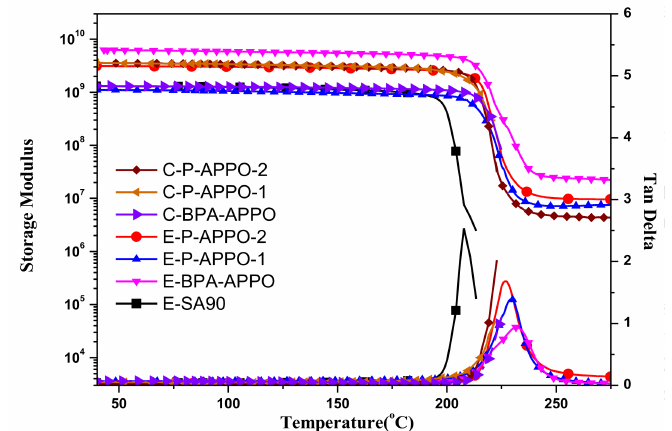
Figure 7. DMA thermograms of the prepared